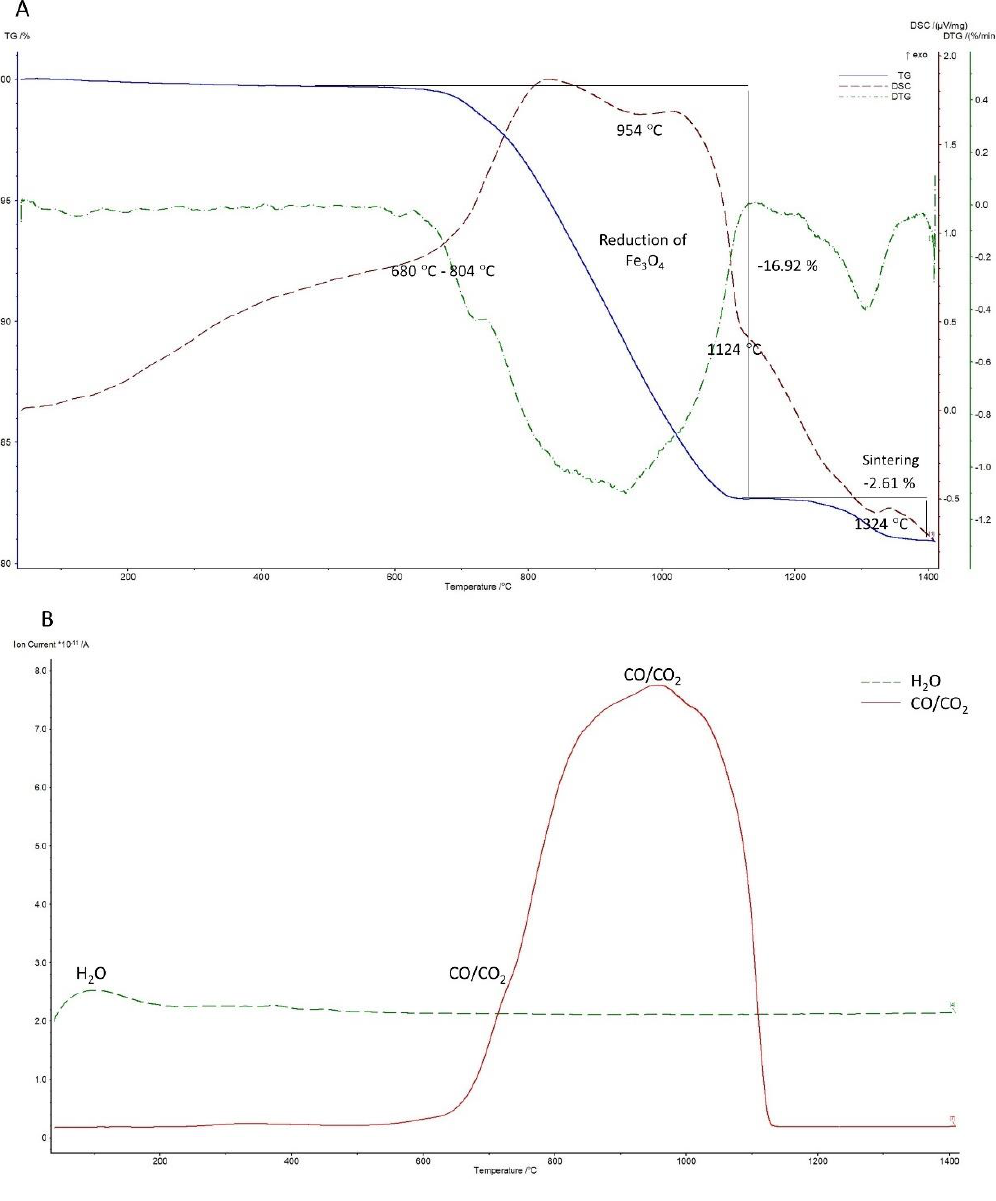
Figure 5. Thermal analysis of BOF sludge under argon atmosphere: ( A ) TG/DTA; ( B ) Mass spectroscopy.